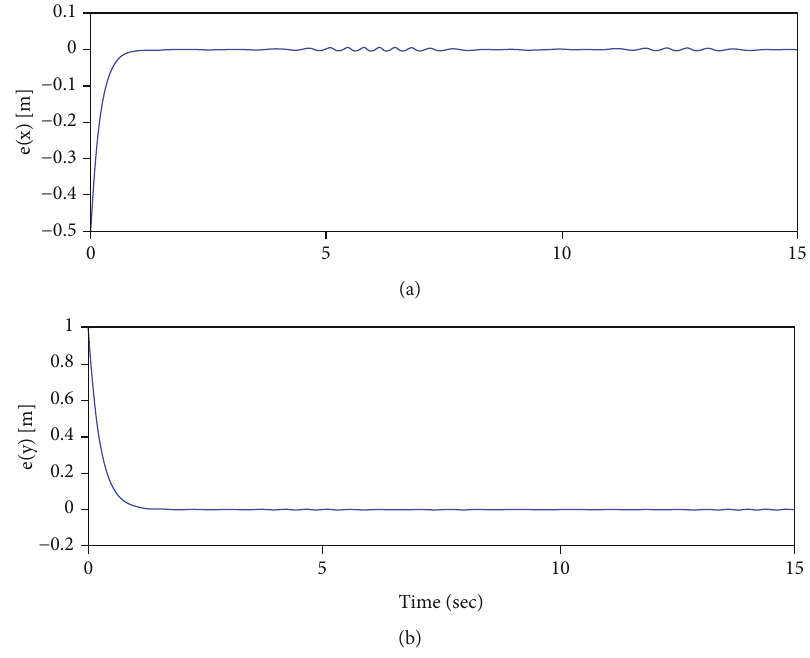
Figure 6: Trajectory error around X and Y